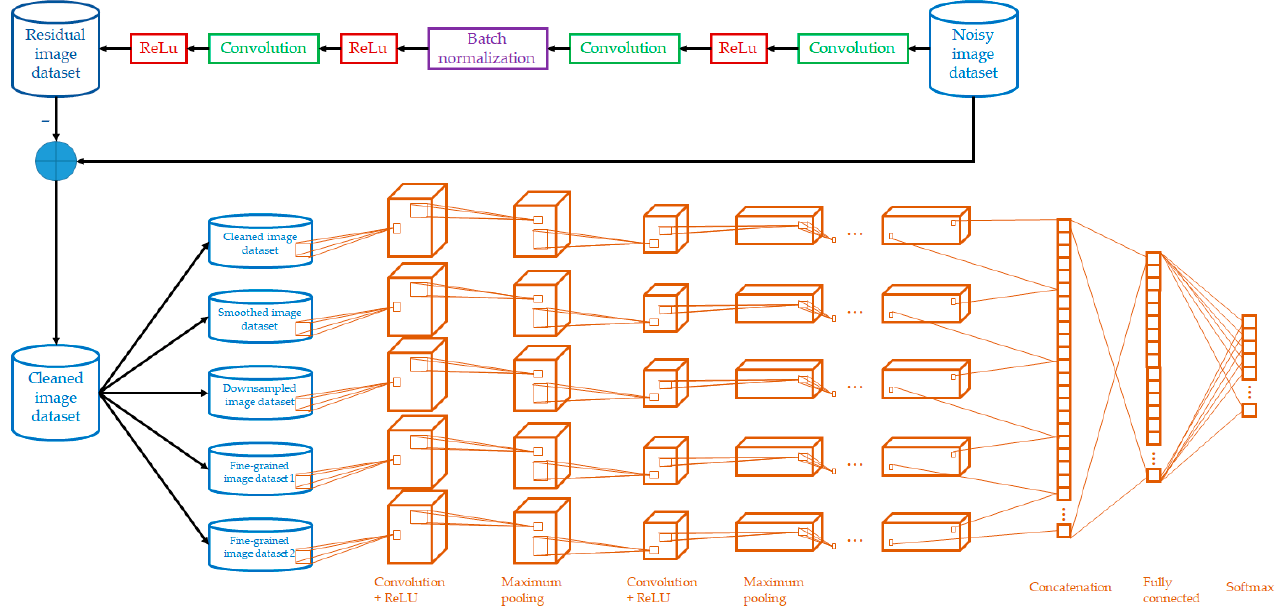
Figure 1. Architecture of the MSDCNN.